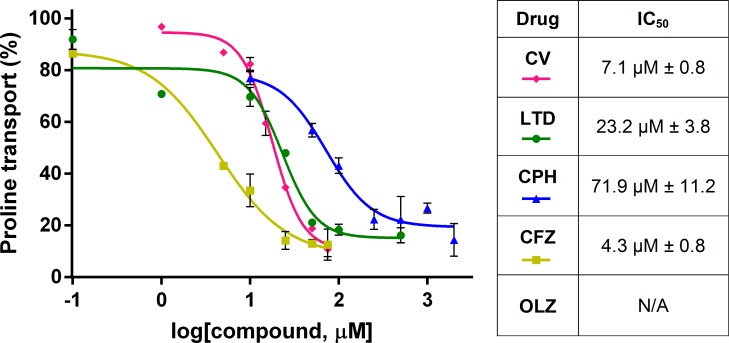
Calculation of CV structural analogues concentrations required to inhibit 50% of proline transport activity (IC50).The IC50s were calculated for three of the four CV analogues. It was not possible to calculate an IC50 for OLZ since this compound produced the death of parasites in the lapse time of the assay in concentrations over 300 μM. The data is expressed as the mean ± standard deviation and corresponds to three independent experiments. CV, crystal violet. LTD, loratadine. CPH, cyproheptadine. OLZ, olanzapine. CFZ, clofazimine. N/A, not available.